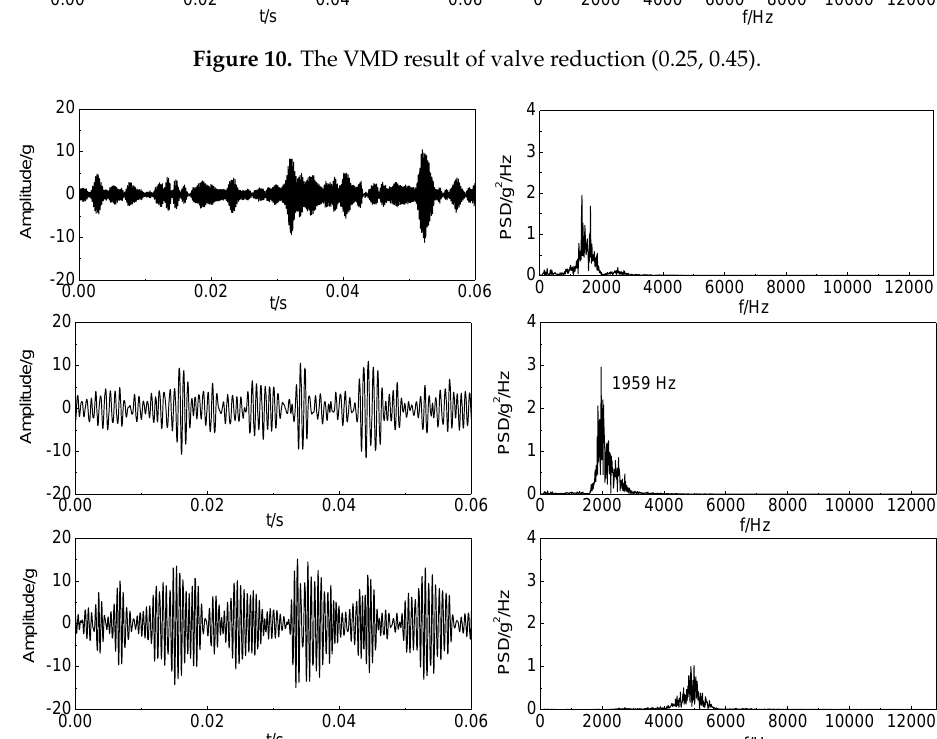
Figure 11. The VMD result of valve increase (0.35, 0.55).